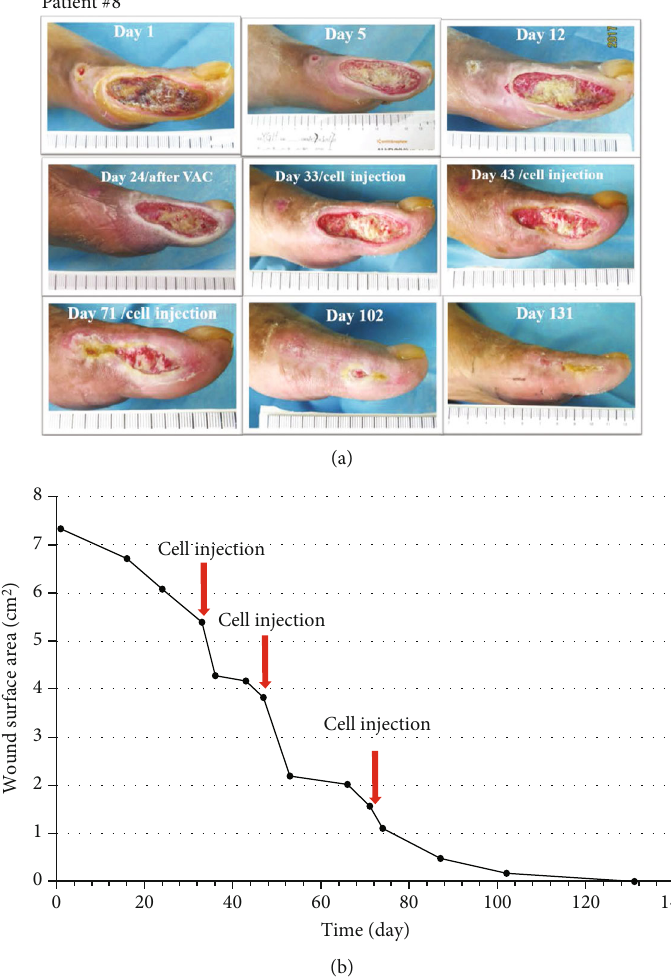
Figure 3: Photographs of ulcer before and after treatment (a) with depiction of wound surface area (b). Patient #8, a 64-year-old man with an 11-year history of type 2 diabetes, had the wound on his left foot for one month (Wagner 3); moreover, the wound area was 7.33cm 2 with bone exposure after debridement of the fi rst